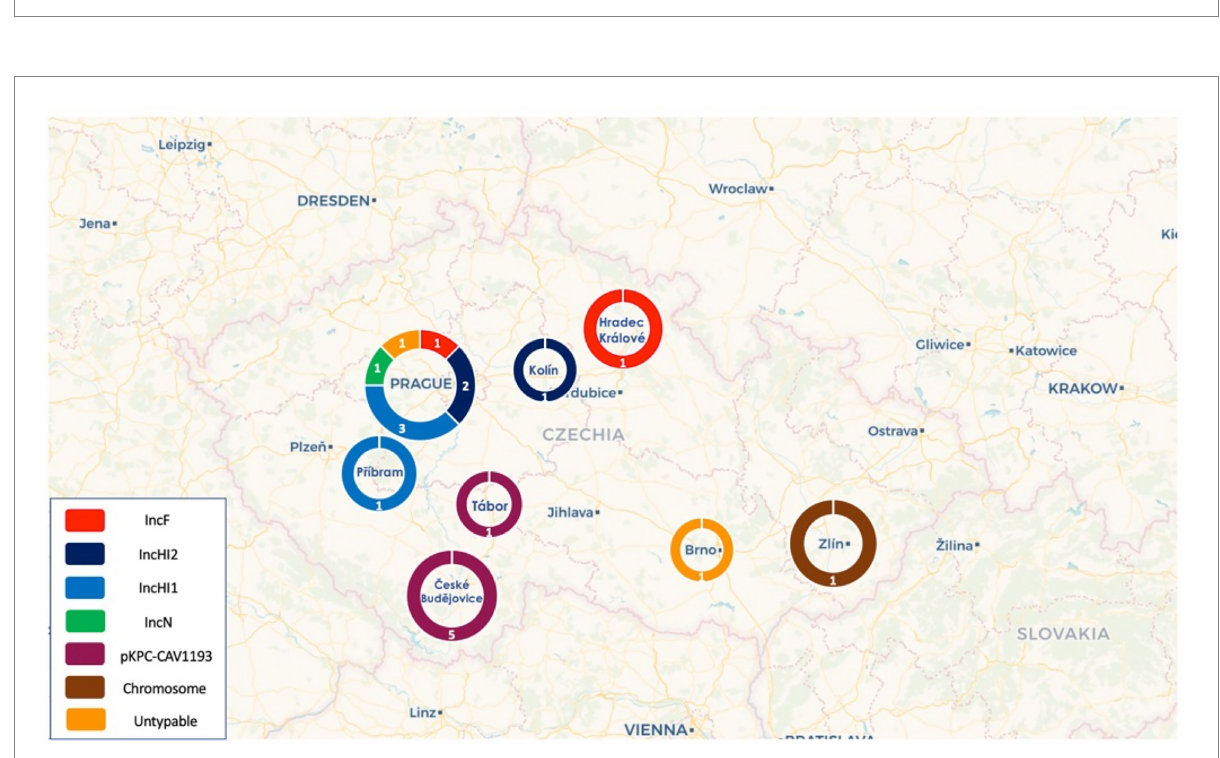
FIGURE 2 Distribution of the different plasmid types across the cities in the Czech